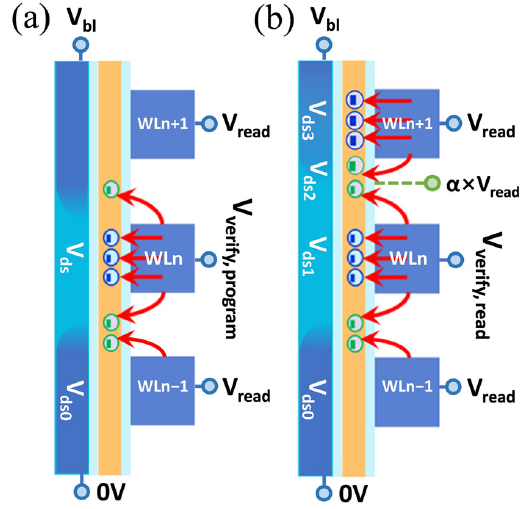
Figure 3. Schematic boundary conditions of operation bias applied to the victim WLn and neighbor WLs ( a ) before WLn+1 is programmed and ( b ) after WLn+1 is programmed. The channel potential variations of each cell are also reflected.